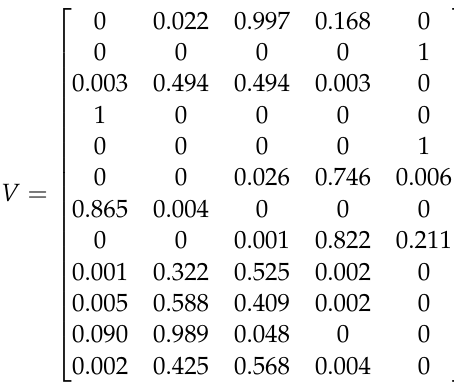
of C 7 Urbanization level belonging to each